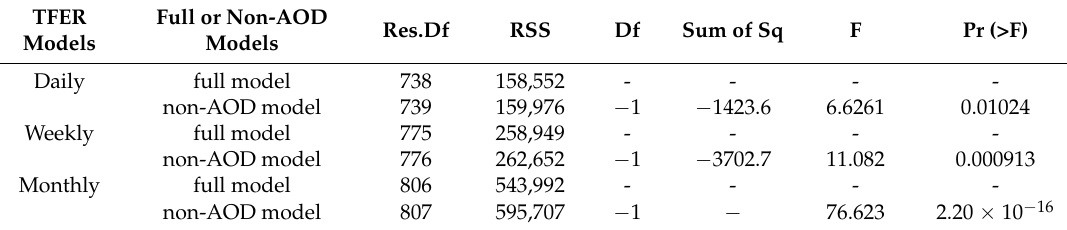
Table 2. F tests between the full and non-AOD models for the first-stage nested TFER